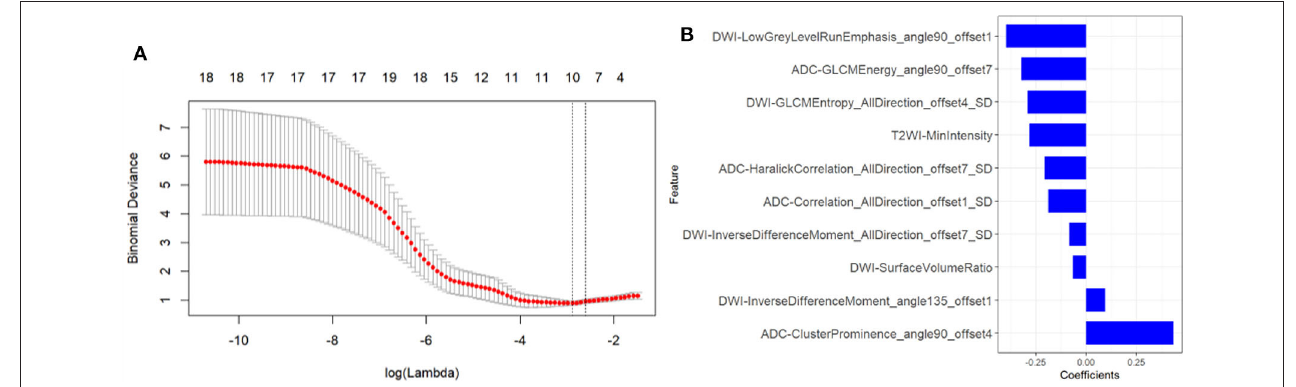
FIGURE 3 | Texture feature selection. (A) Tuning parameter ( λ ) selection in the LASSO model used tenfold cross-validation via minimum criteria. The partial likelihood deviance was plotted versus log ( λ ). The dotted vertical lines were drawn at the optimal values using the minimum criteria and the 1-SE criteria. (B) The most predictive subset of feature was chosen and the corresponding coefficients were evaluated.